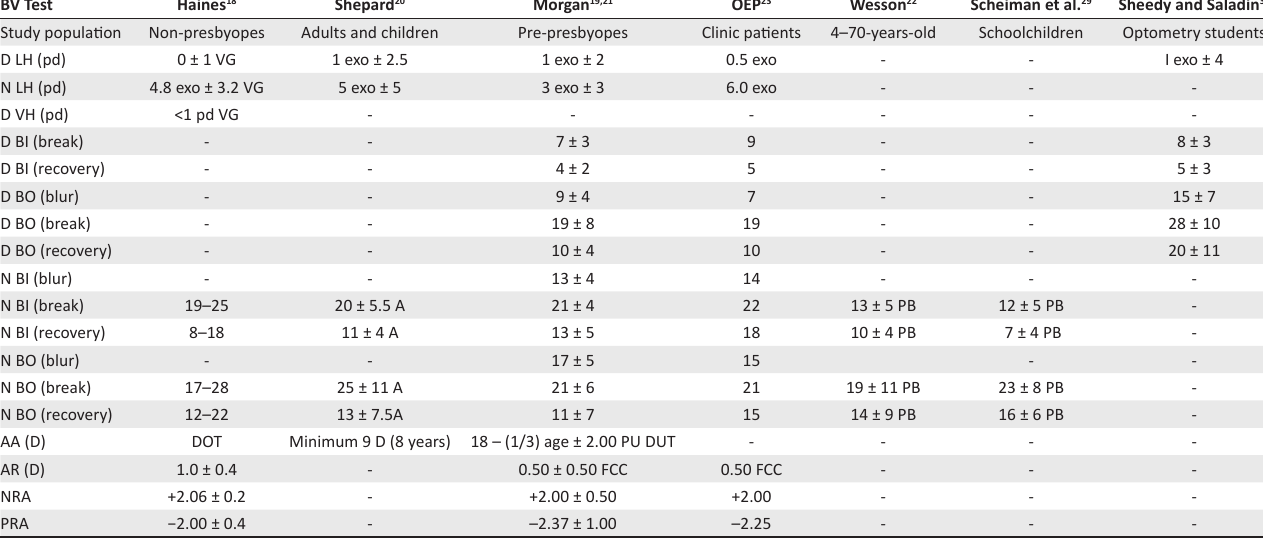
TABLE 1: Expected values for vergence and accommodative functions from the early American studies between 1910 and 1999. BV